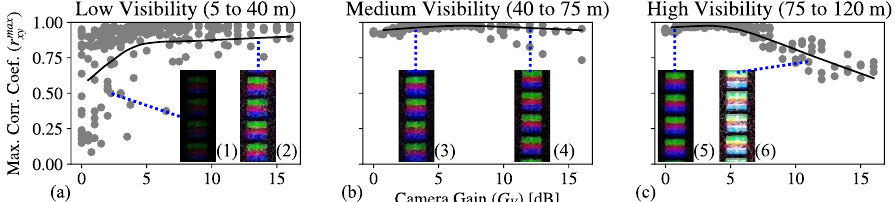
Figure 7. Maximum correlation data (gray dots) from fog-emulation experiments, separated by levels of ( a ) low, ( b ) medium, and ( c ) high visibility and their respective locally estimated scatterplot smoothing (LOESS) regression for s = 0.5 (black curves). The area encircled in ( a ) is the region of image frames affected by the fog attenuation and in ( b ) by gain saturation. Insets are Region of Interest (ROI) extraction examples: (1) for low visibility and low gain, (2) low visibility and high gain, (3) medium visibility and low gain, (4) medium visibility and high gain, (5) high visibility and low gain, and (6) high visibility and high